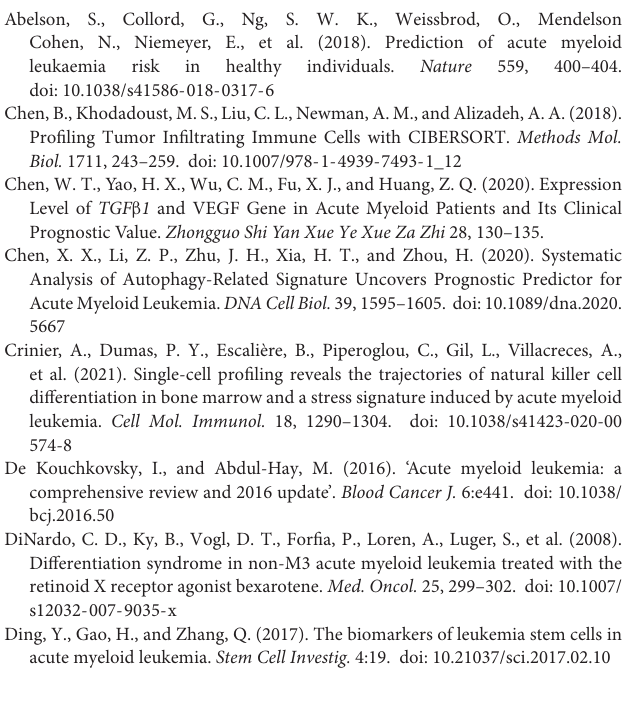
represented different classifications. Samples with often changed color classification before and after different k values represented unstable classification, and more samples with unstable classification were indicative of more unstable classification under the k value. Supplementary Figure 2 | Prediction analysis of survival time between different groups obtained by clustering at K = 3. Results showed that there were significant differences in survival between the three groups, with subgroup 1 showing the worst prognosis and subgroup 3 showing the best prognosis. Supplementary Figure 3 | A correlation analysis of immune factors and risk scores. (A) Risk score was significantly positively correlated with monocytes, macrophages M2, and activated CD4 memory T cells, and negatively correlated with eosinophils, T cells gamma delta, and mast cells resting. (B) Sensitivity analysis of samples from the high-risk and low-risk groups to immuno-drugs. They were significant between groups by the rank sum test. Risk score notably affected patients’ susceptibility to Bexarotene, Bortezomib, Bryostatin 1, Dasatinib,